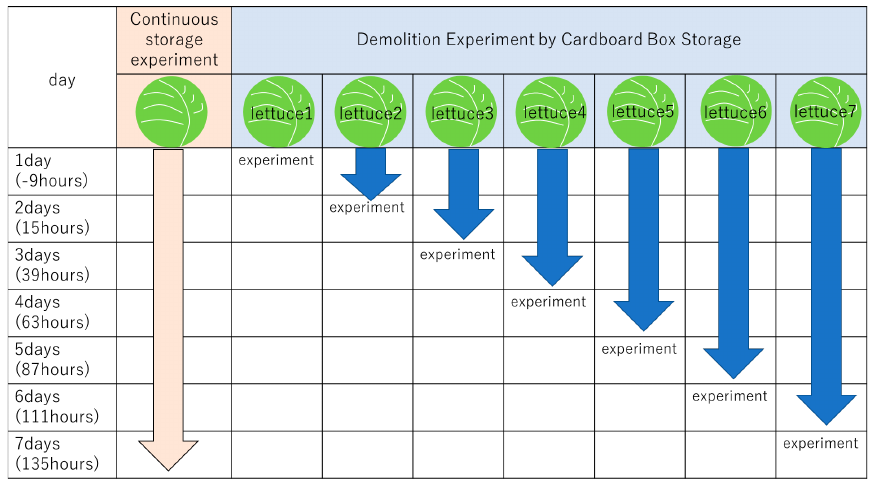
Fig. 1: Outline of experiments. The continuous storage experiment was conducted 9 h after the demolition experiment started. Since the start time of the continuous storage experiment was set to 0 h, the start time of demolition experiment corresponds to -9 h.